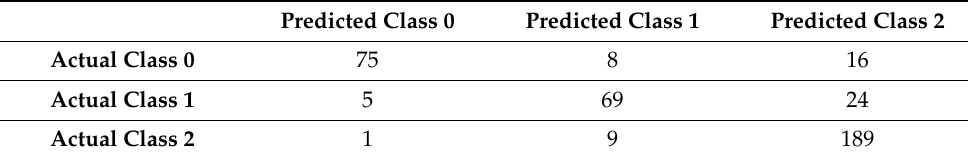
Table 10. Confusion matrix of dipped joint severity classification from the convolutional neural network (CNN) model.